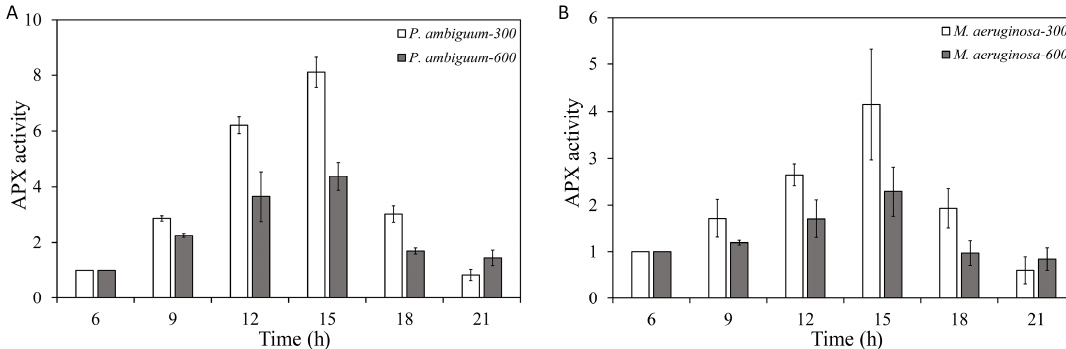
Figure 4. Diurnal variations in the ascorbic peroxidase (APX) activities of P. ambiguum (strain NIES 2119) ( A ) and M. aeruginosa (strain NIES 111) ( B ). The numbers 300 and 600 represent the maximum PAR intensities (in µ mol·m −2 ·s −1 ) for two different treatment conditions, where the maximum PAR intensity was reached at 12:00 h. The error bars represent the standard deviations.